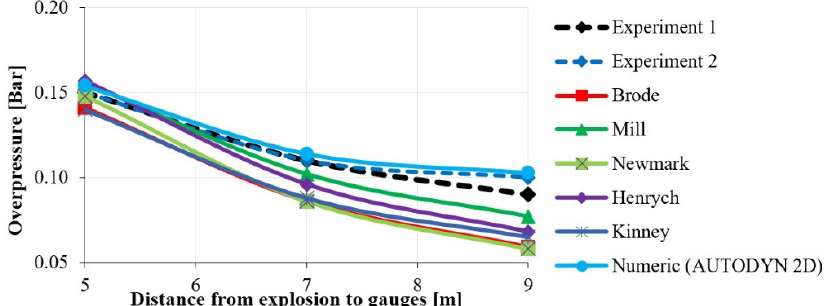
Figure 2. Overpressures as a function of the explosion distance of a propane gas tank with a volume of 27.2